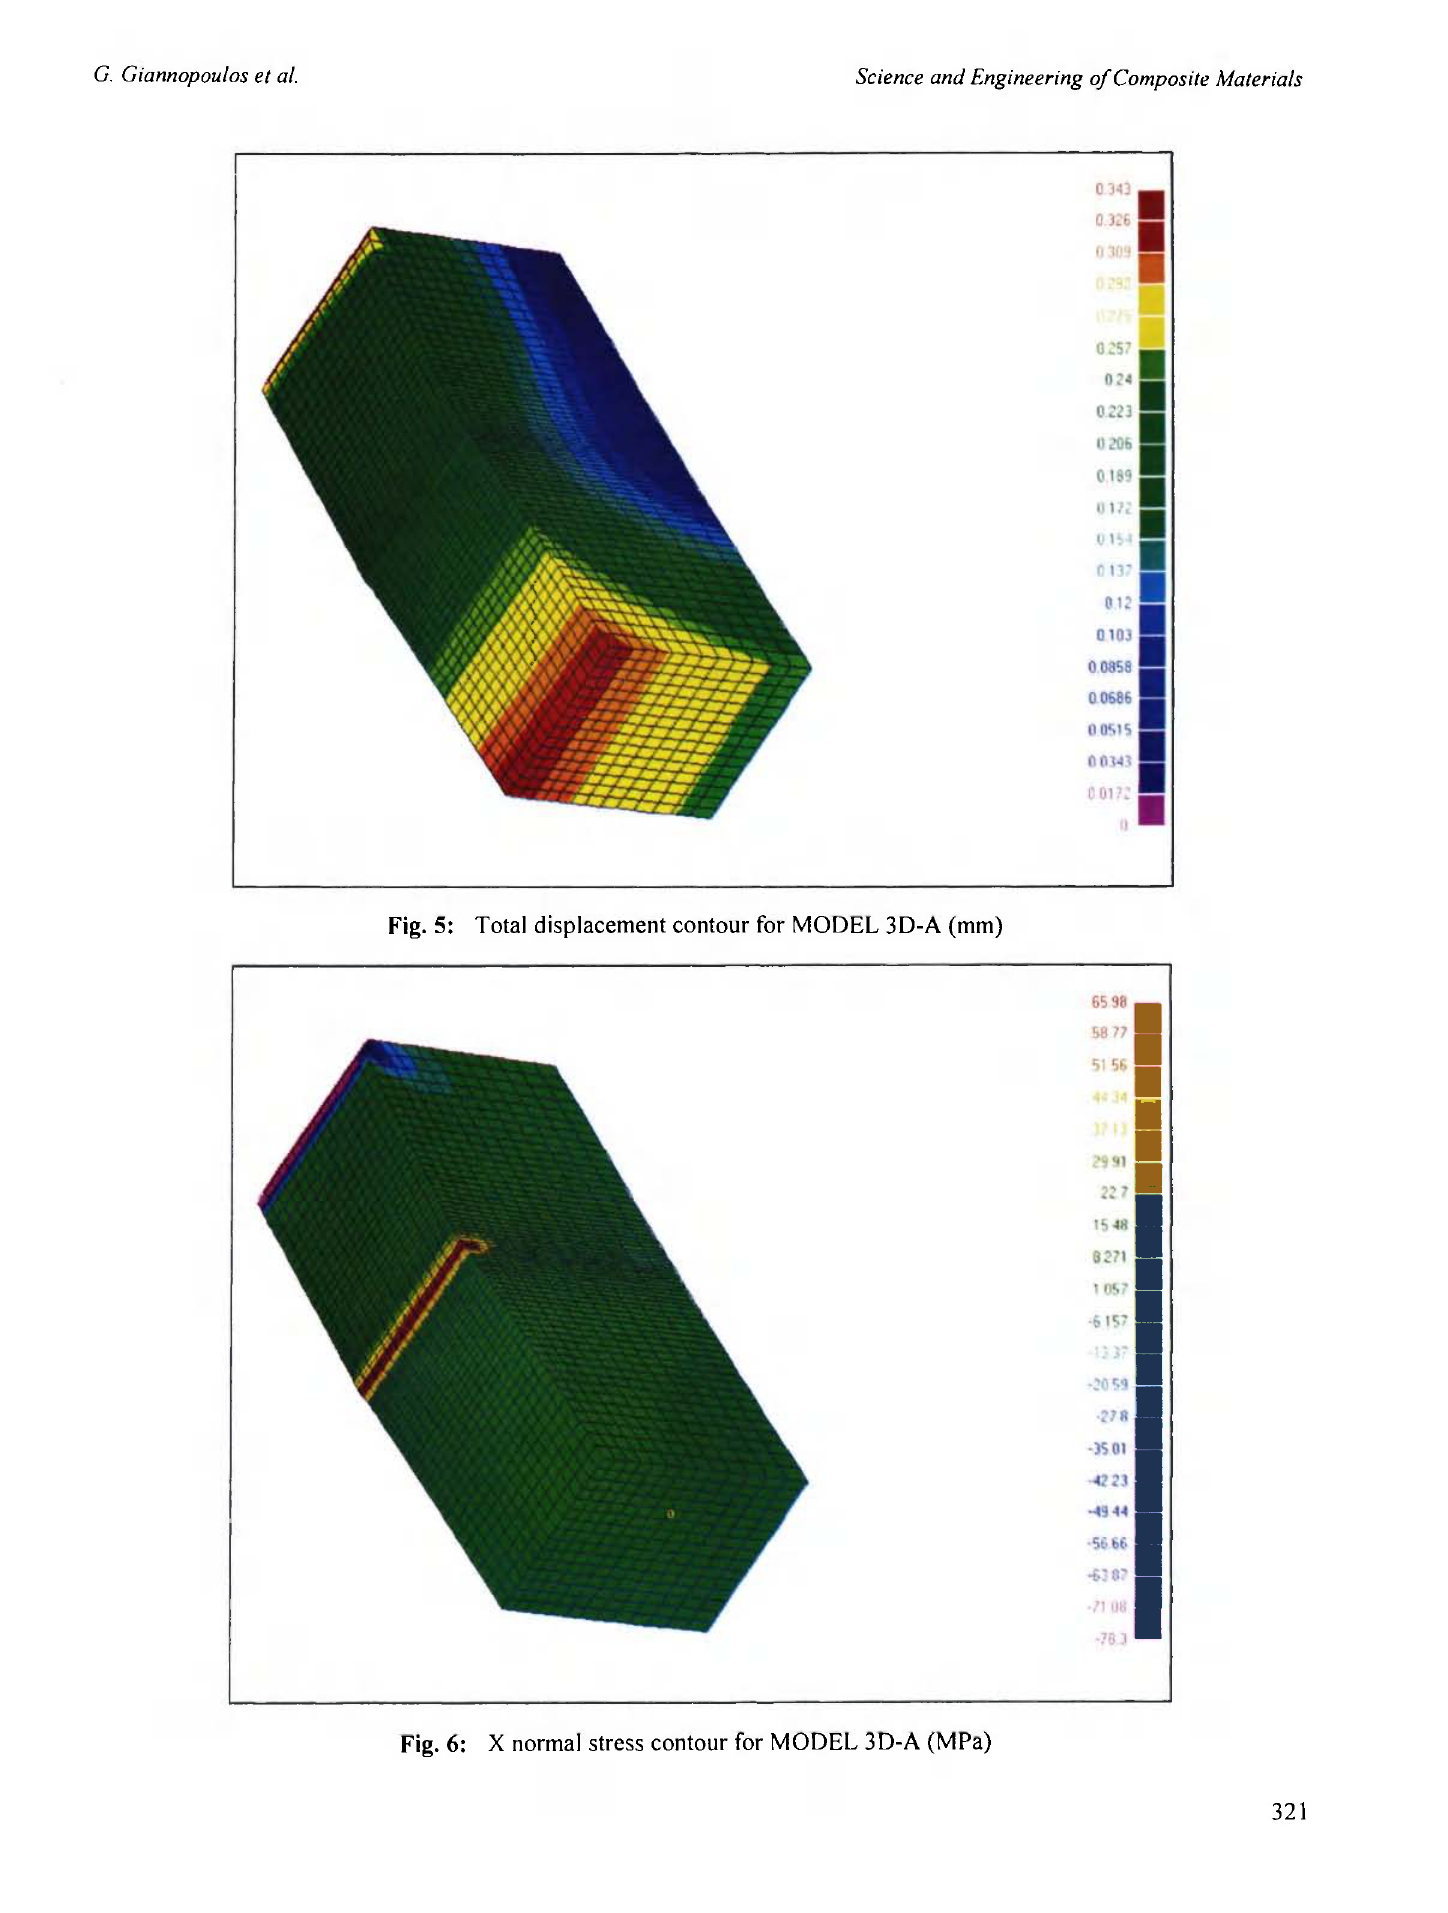
Fig. 6: X normal stress contour for MODEL 3D-A (MPa)